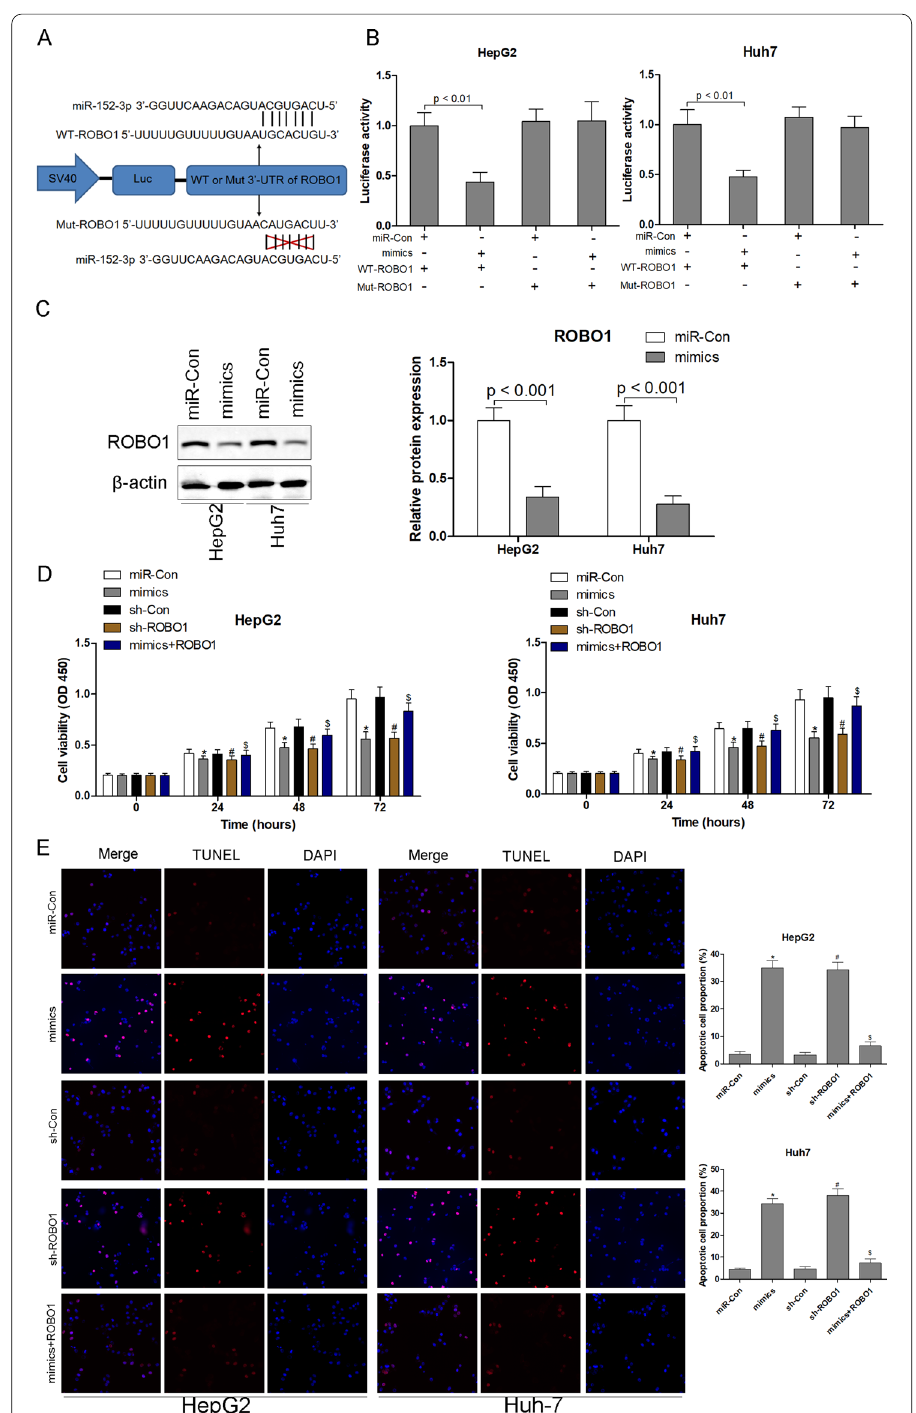
Fig. 8 Validation of ROBO1 as a gene target of miR-152-3p. miR-152-3p binds with the 3 ′ -UTR of ROBO1 ( A ). In vitro luciferase activity in HepG2 and Huh7 cells ( B ). ROBO1 protein expression in HepG2 and Huh7 cells with miR-152-3p mimics transfection ( C ). Cell proliferation ( D ) and apoptosis ( E ) of HepG2 and Huh7 cells were analysed using CCK8 and TUNEL. * p < 0.05 versus miR-Con group; # p < 0.05 versus sh-Con group; $ p < 0.05 versus mimics